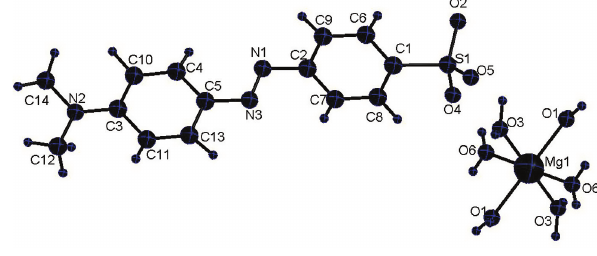
Table 1: Data collection and handling.